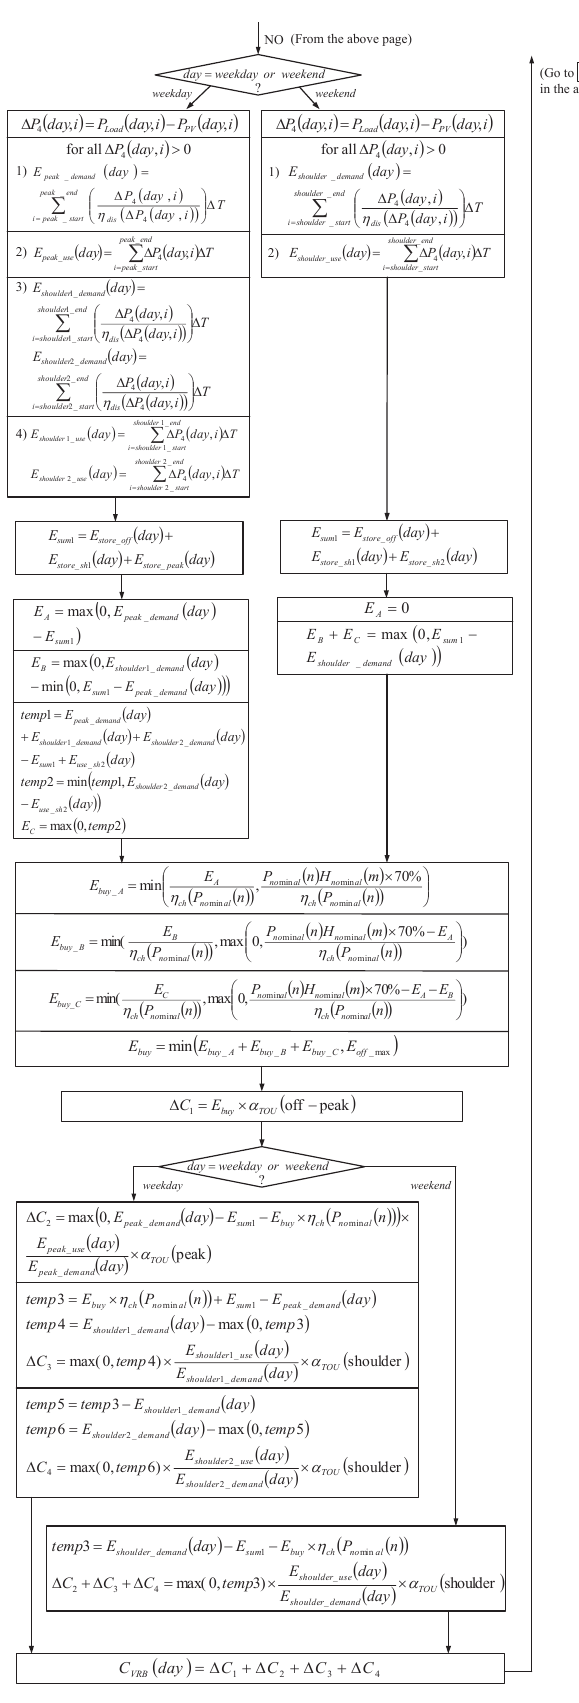
Figure 6. Flow chart of the proposed optimal sizing